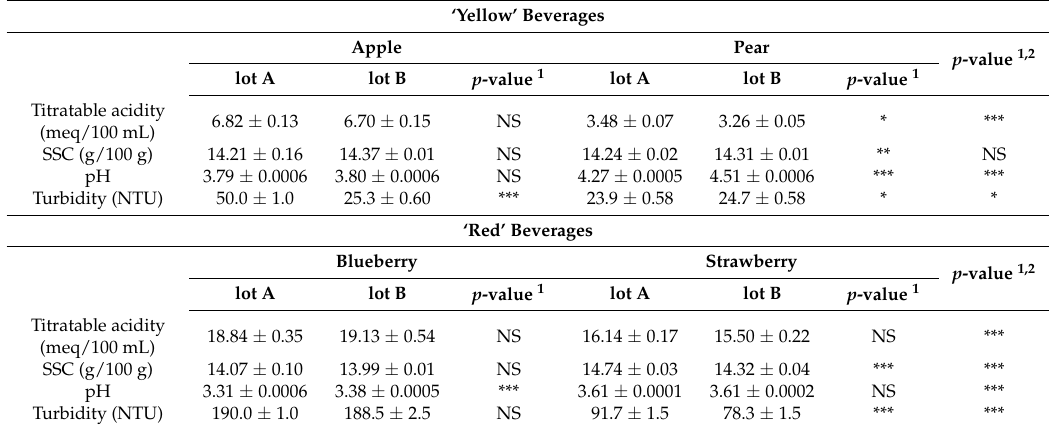
Table 3. Physicochemical analysis after pasteurization in A and B lots of fruit-RCW beverages and significance of Student’s t test ( p -value) for comparison between lots within the same beverage and comparison between beverages within the same